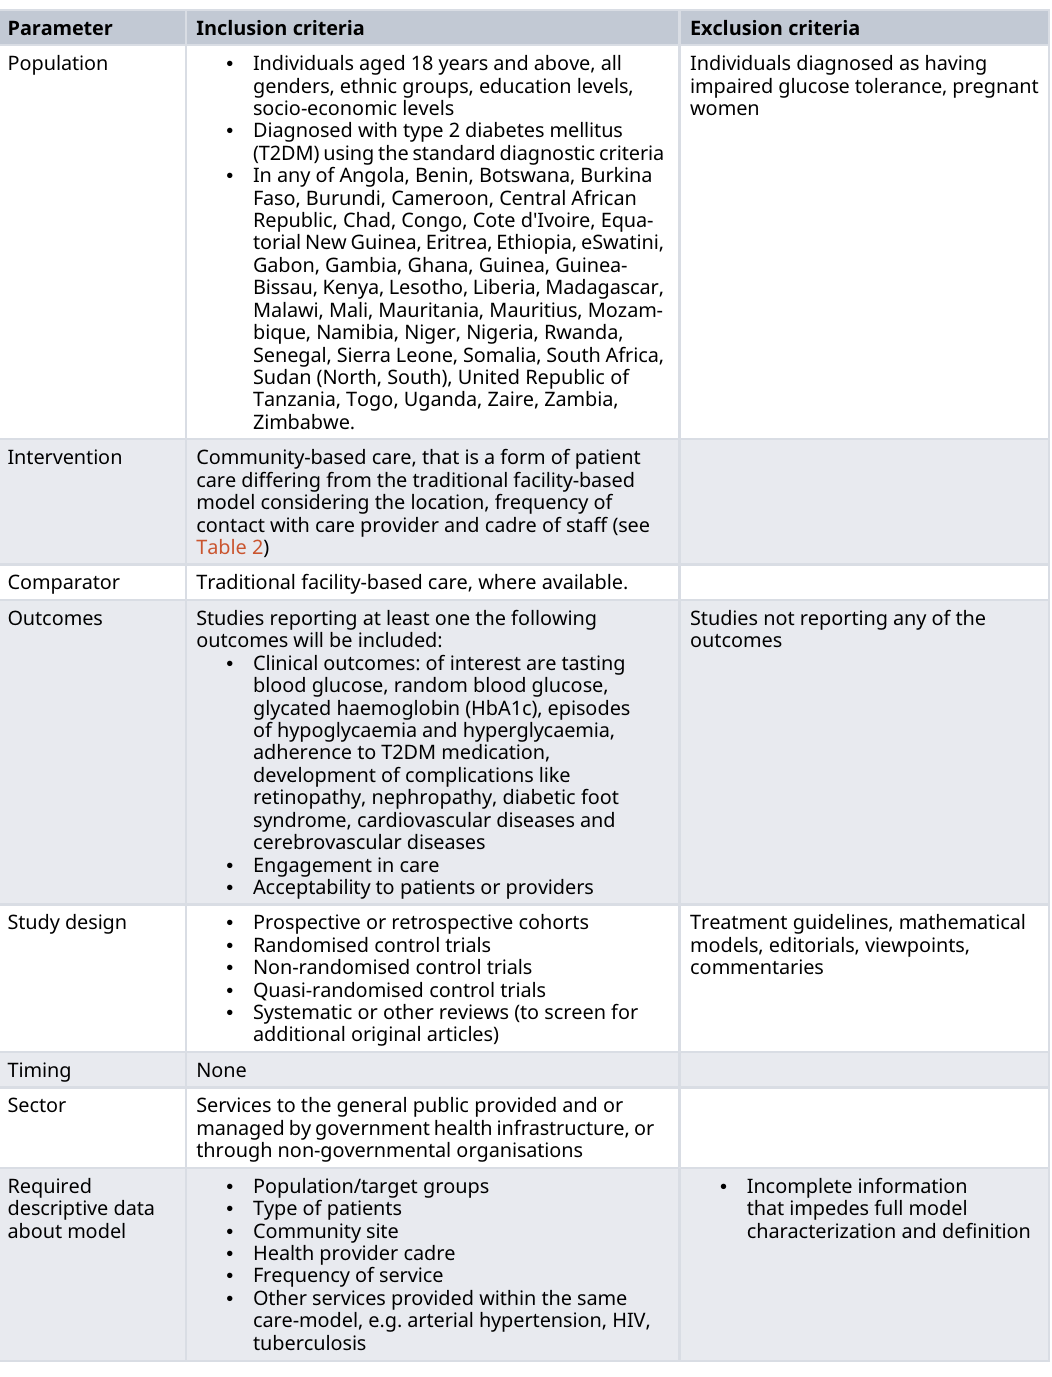
Table 3. Inclusion/exclusion criteria Parameter Inclusion